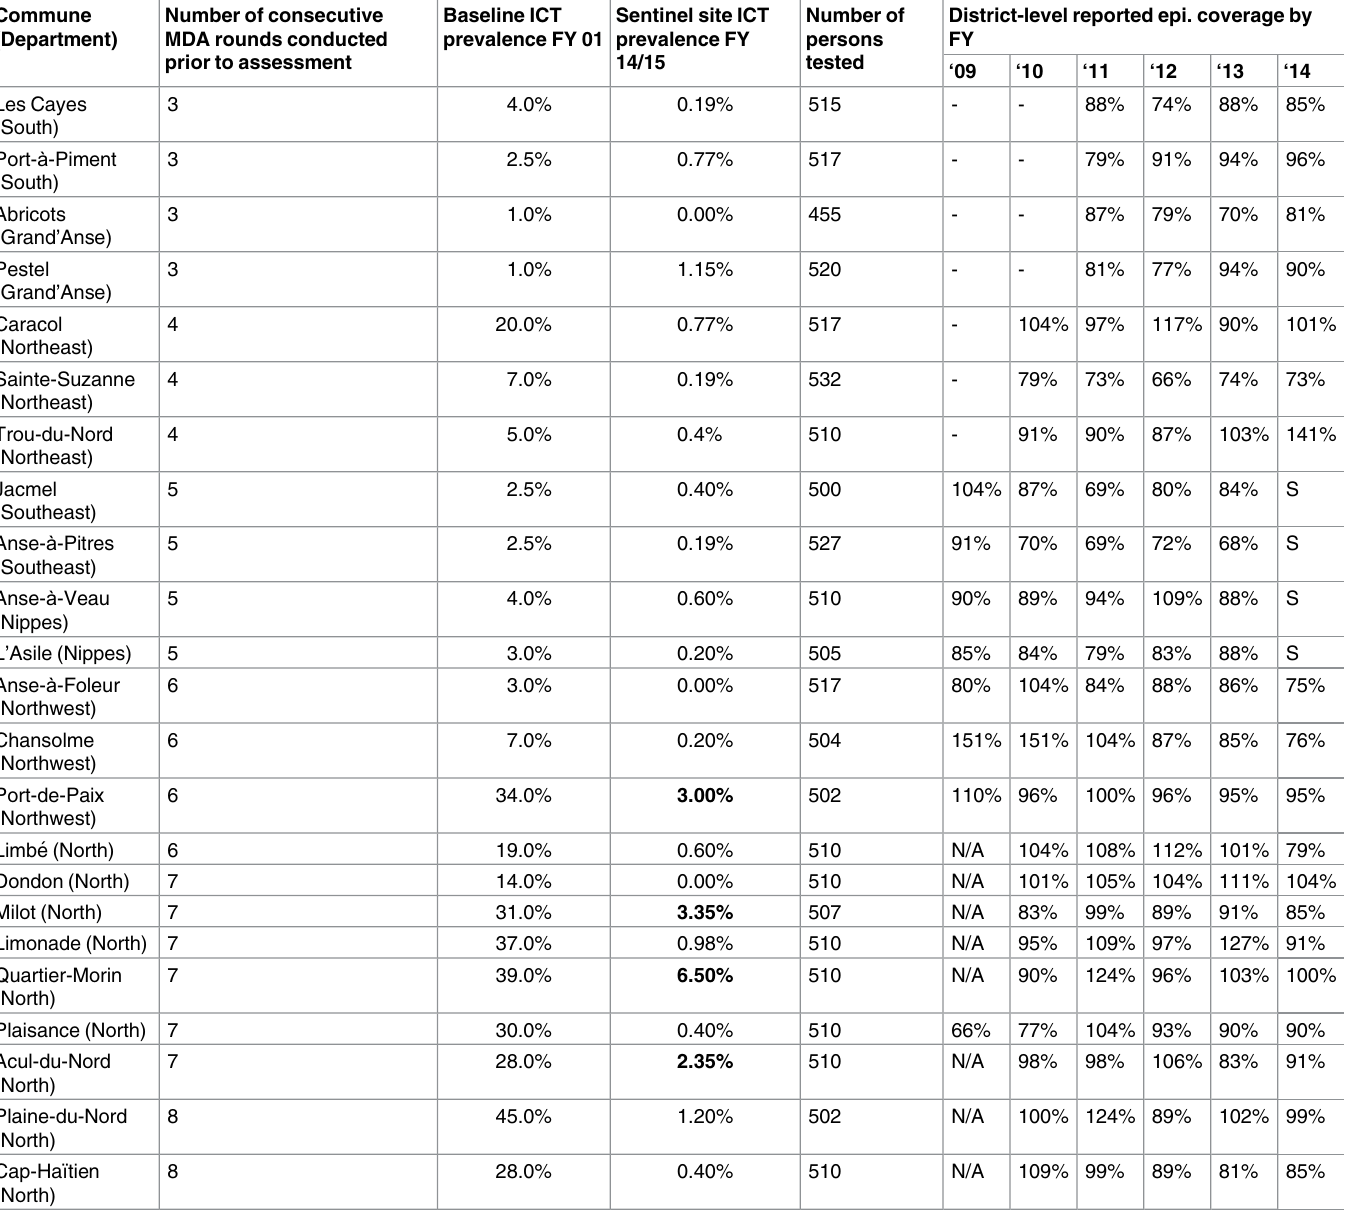
Table 4. Sentinel sites and spot checks